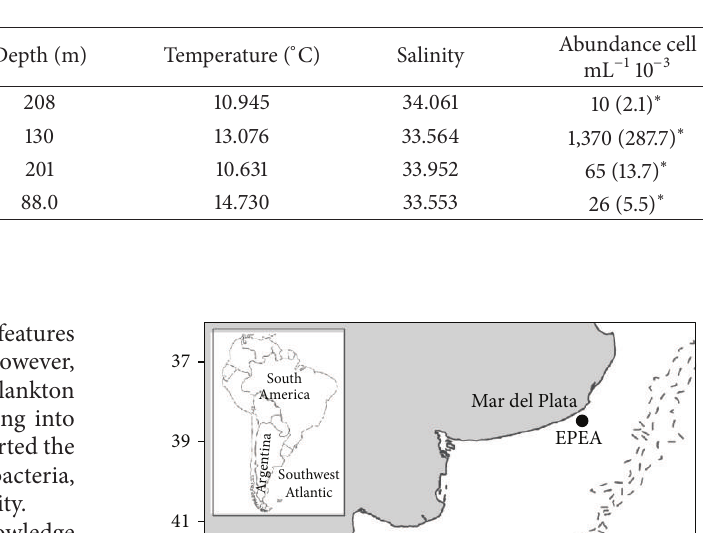
Table 1: Localization and environmental parameters of Patagonian stations at the Argentine Sea. Data were registered by the Instituto Nacional de Investigaci´on y Desarrollo Pesquero (INIDEP), Gabinete de Oceanograf´ıa F´ısica, Base Regional de Datos Oceanogr´aficos (BaRDO).